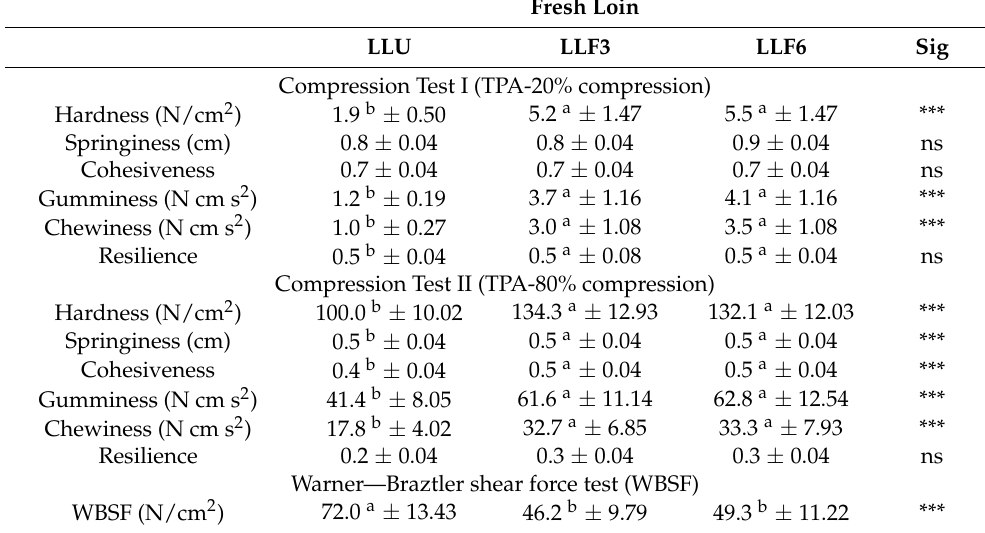
Table 3. Effect of freezing on textural properties of fresh